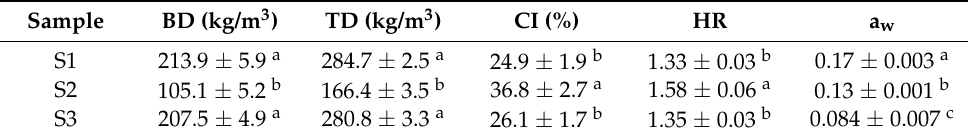
Table 1. The flow properties and water activity (a w ) of the resulting